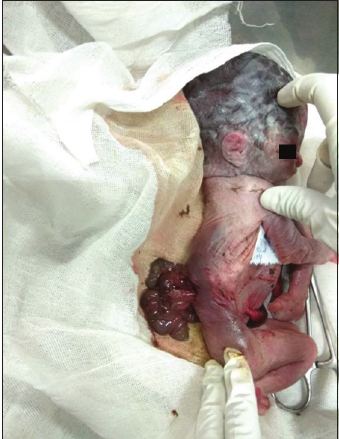
Figure 1: Defect on the right posterolateral aspect. No membrane covering bowel loops. Umbilicus away from defect in normal